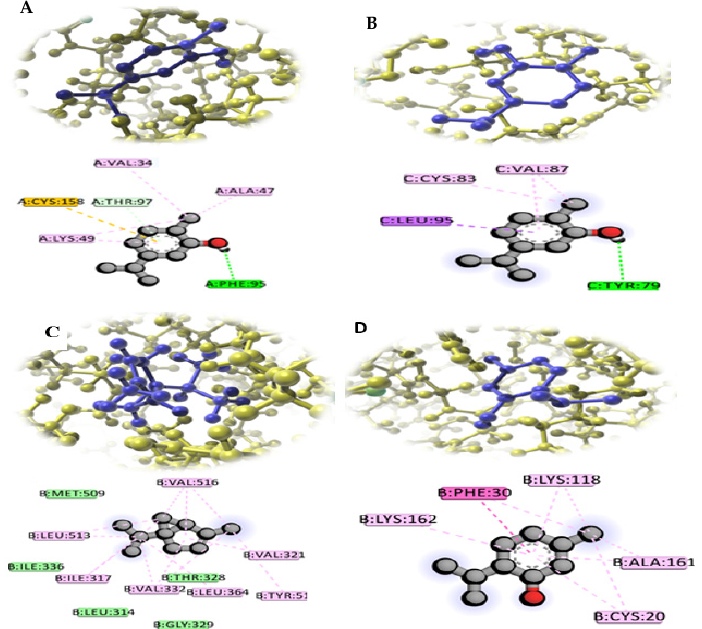
Figure 6. The 2D and 3D interaction diagrams of the binding of carvacrol with Hog1 ( A ) and PacC ( B ), the binding of α - thujene with Mkk12 ( C ) and Thymol, and the binding of Rho1 ( D ) with Fusarium virulence proteins.